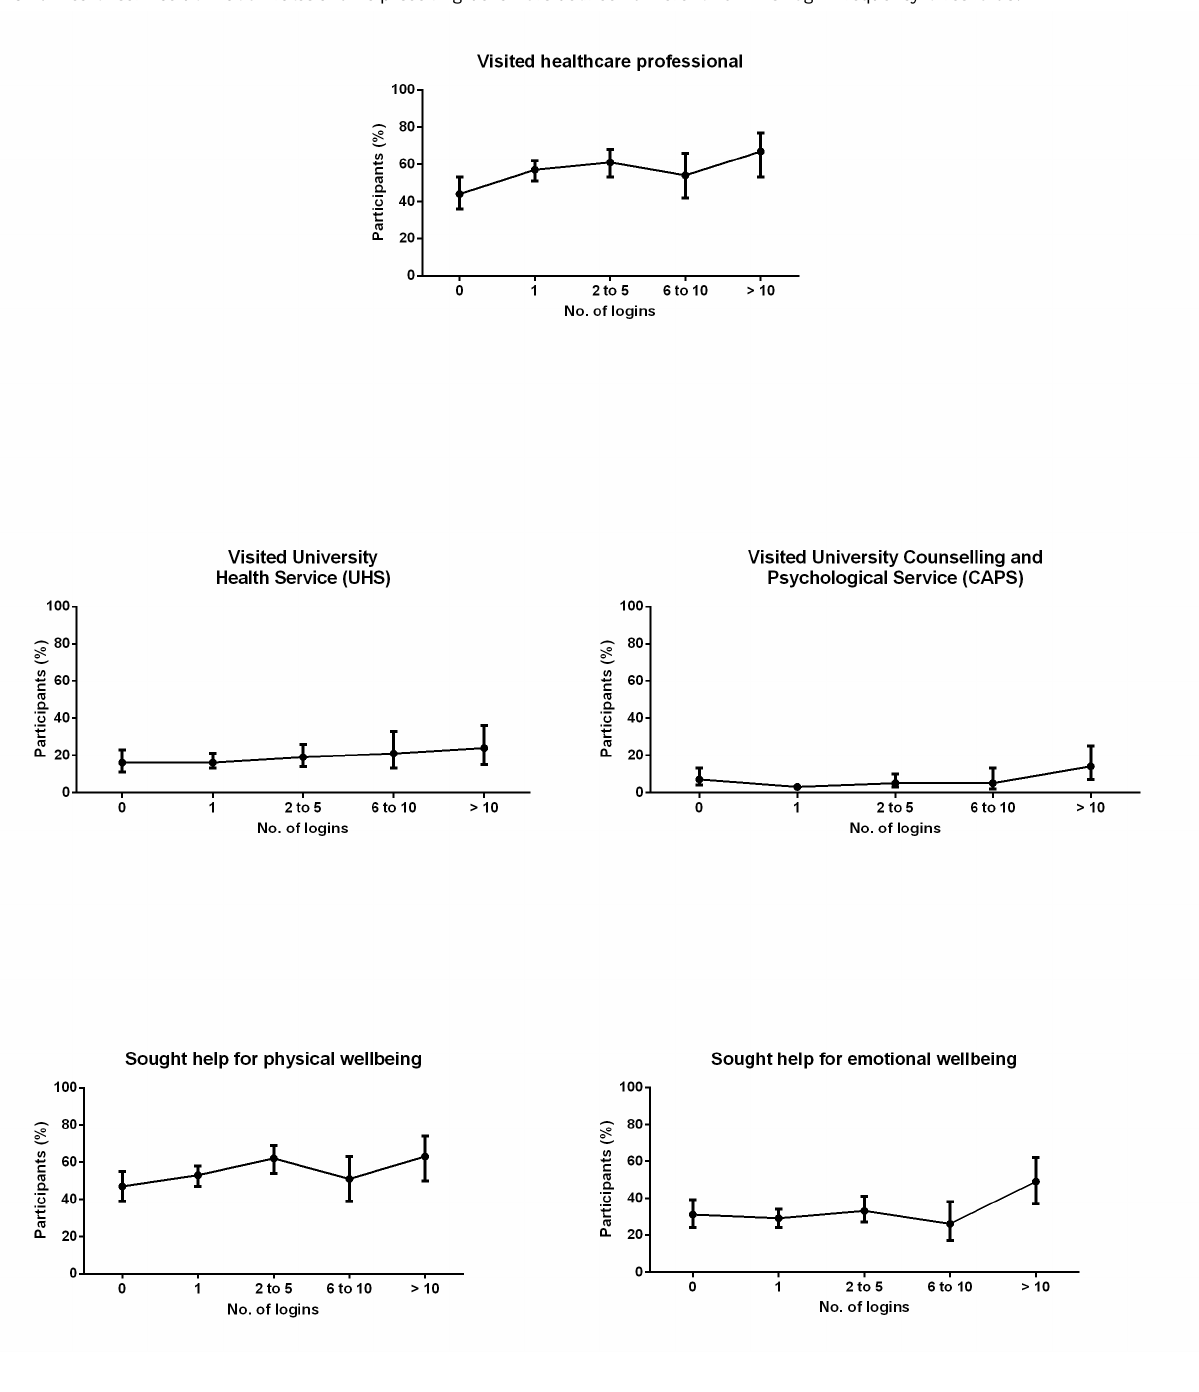
Figure 4. Health service utilization rates and help-seeking behaviors between different PCHMS login frequency